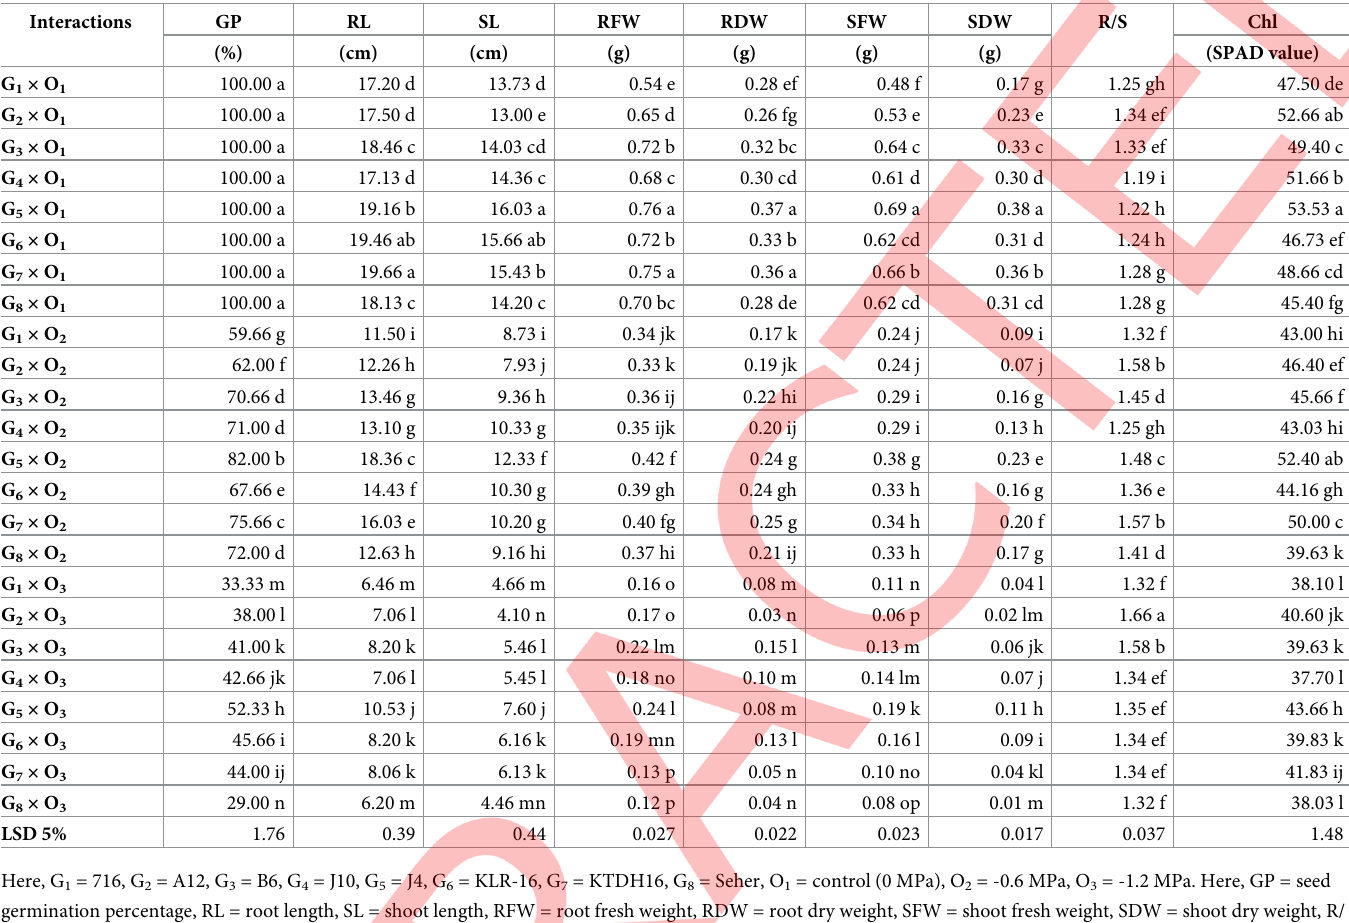
Table 4. The impact of wheat genotypes by different osmotic potentials’ interaction on seed germination and growth traits of wheat genotypes included in the study.